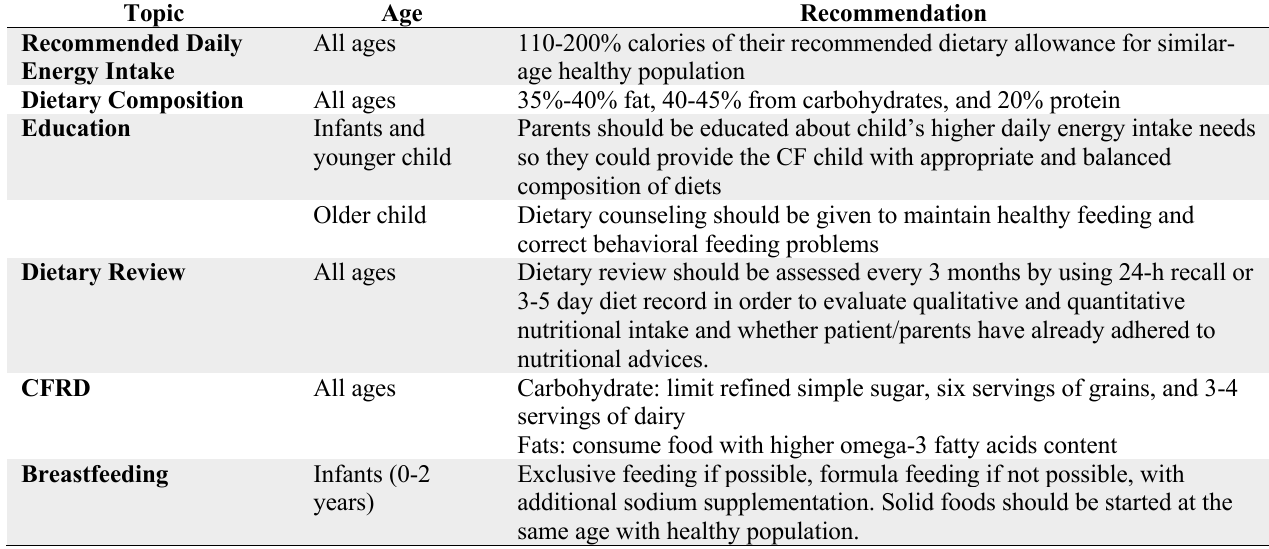
Table 1. The summary of energy and macronutrient recommendation in CF patient 11,16